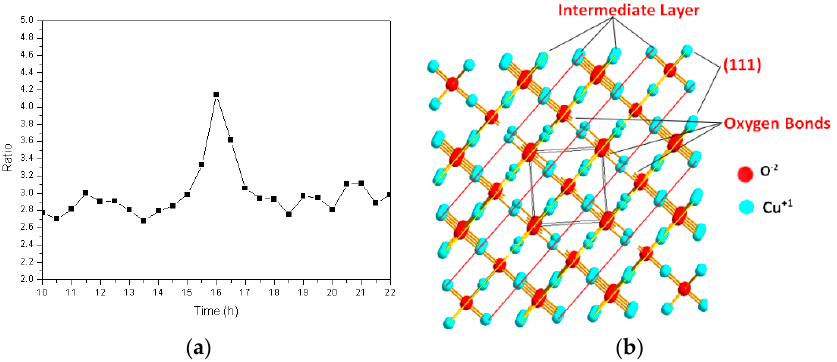
Figure 6. ( a ) The ratio of the intensity of the (111) crystal plane diffraction peak to that of the (200) crystal plane as a function of time; ( b ) Atomic arrangement of the cuprous oxide lattice.